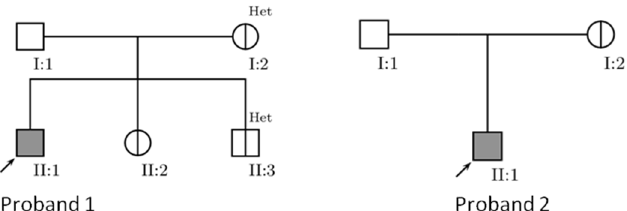
Figure 1. Pedigrees of two analyzed Leber’s hereditary optic neuropathy (LHON) families. I:1 not assessed, a halved circle/square = asymptomatic mutation carrier, Het = heteroplasmy.